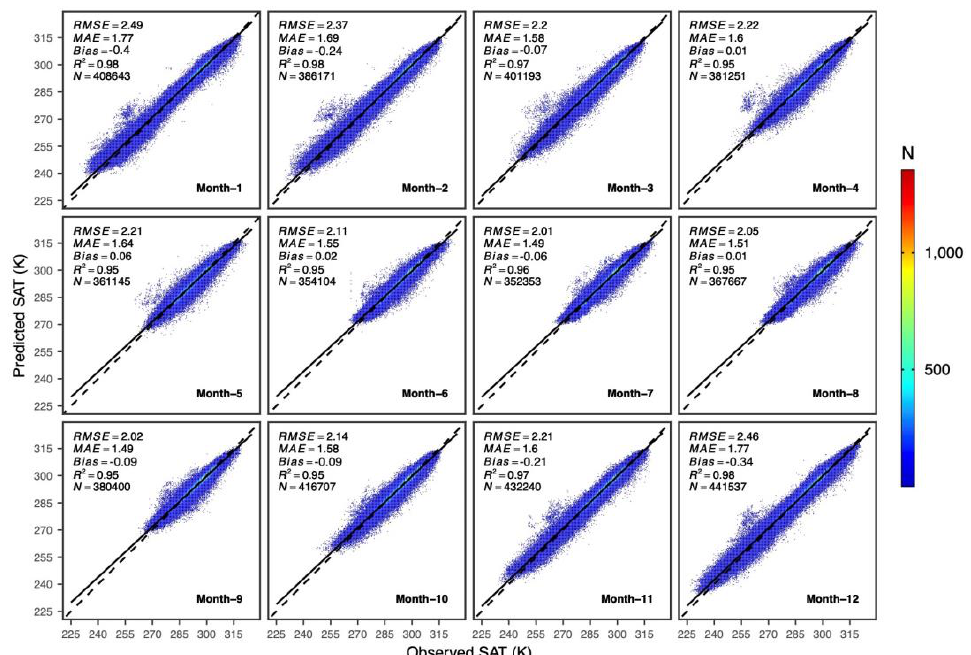
Figure 4. Comparison of mean predictive performance (RMSE) of the STRF model across the months for site-based CV.